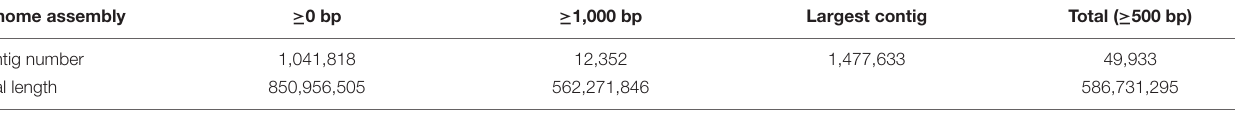
TABLE 1 | Summary of genome assembly and annotation of Eruca sativa . Genome